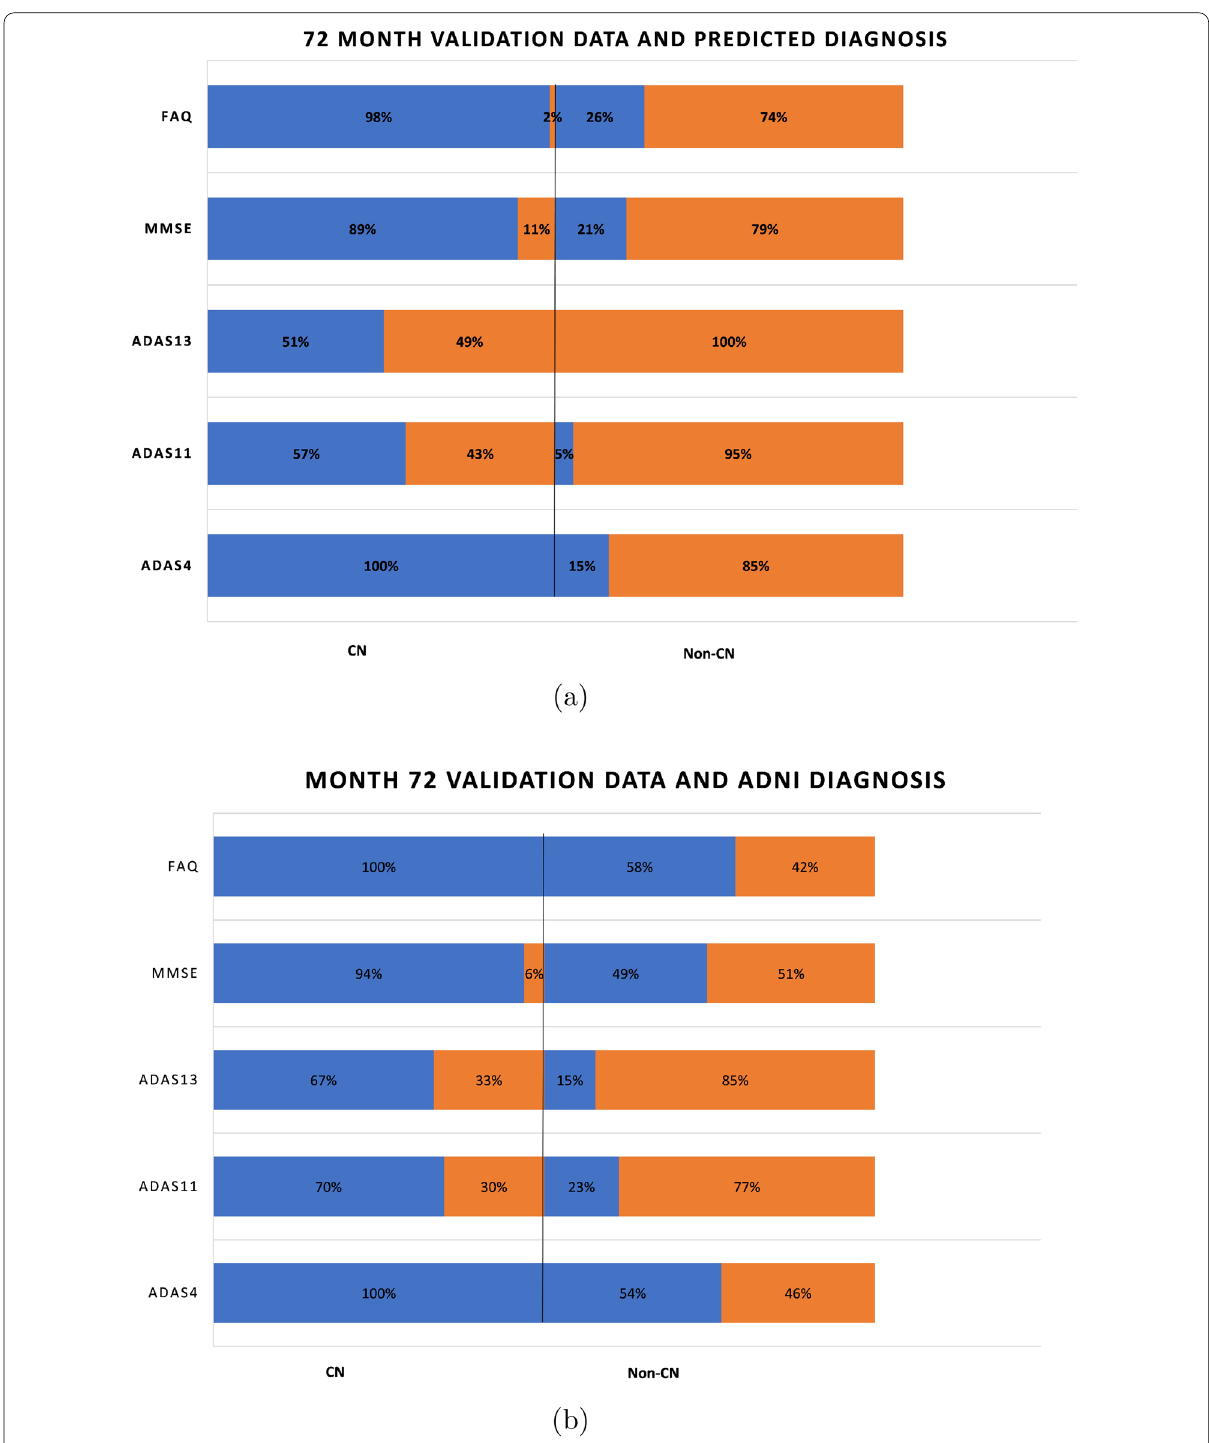
Fig. 7 Proportion of correct and incorrect diagnosis in CN and non-CN categories for validation data at month